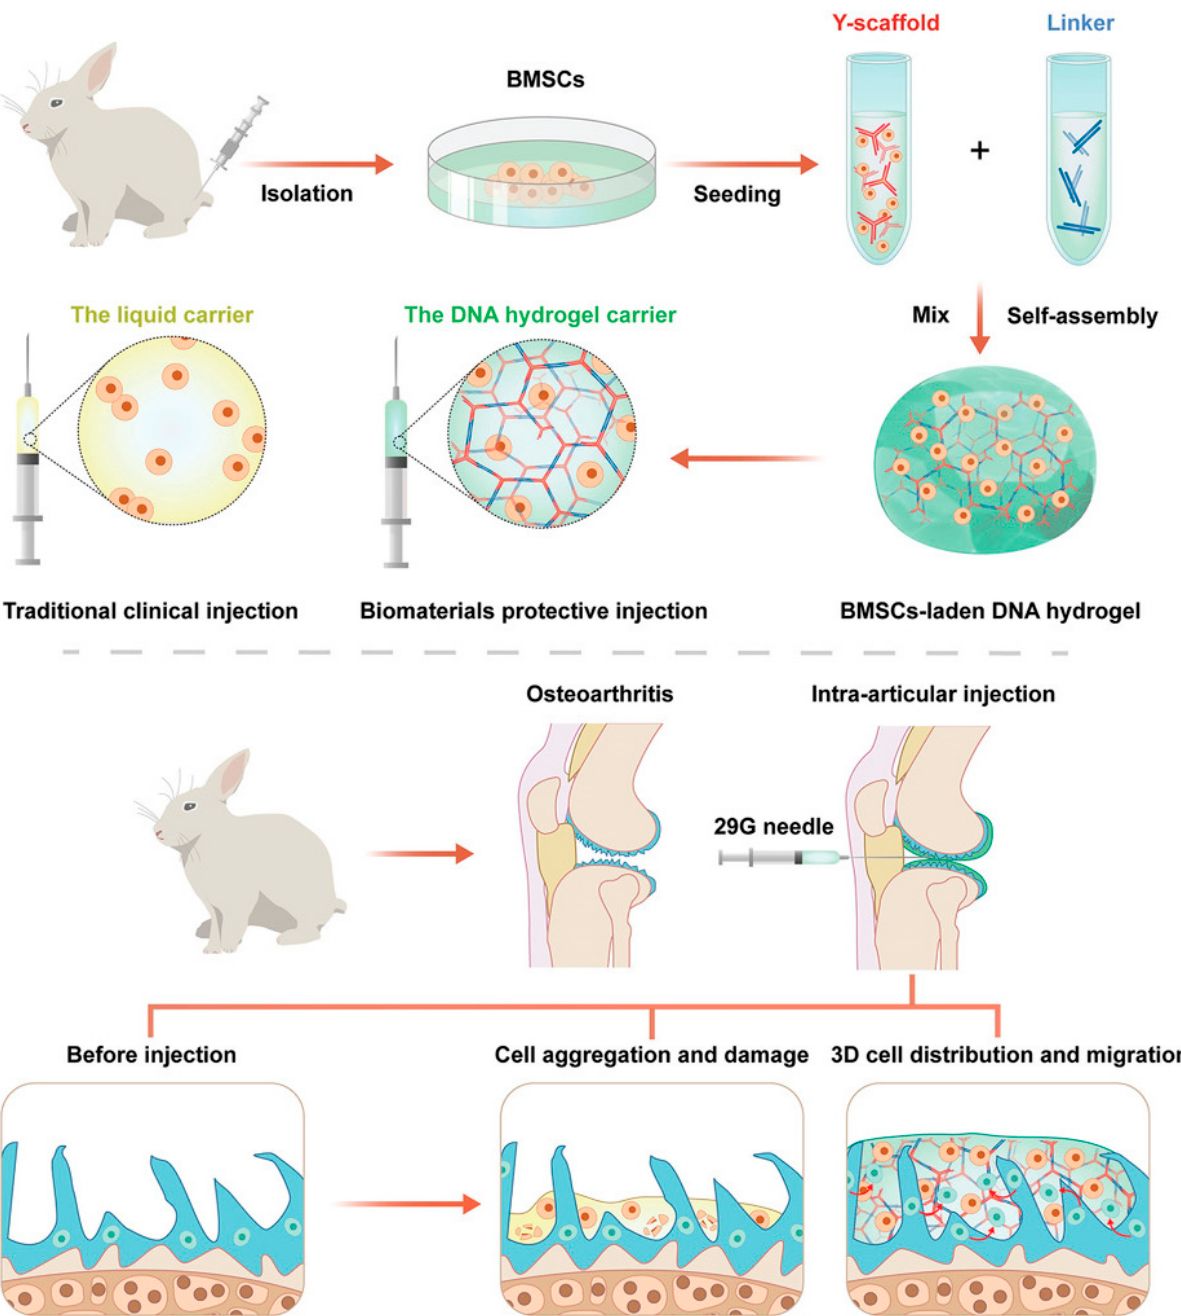
Figure 4. Schematic diagram of an anti-friction MSC delivery system, which showed an improved therapeutic effect on severe OA, Reprinted from Ref. [78].